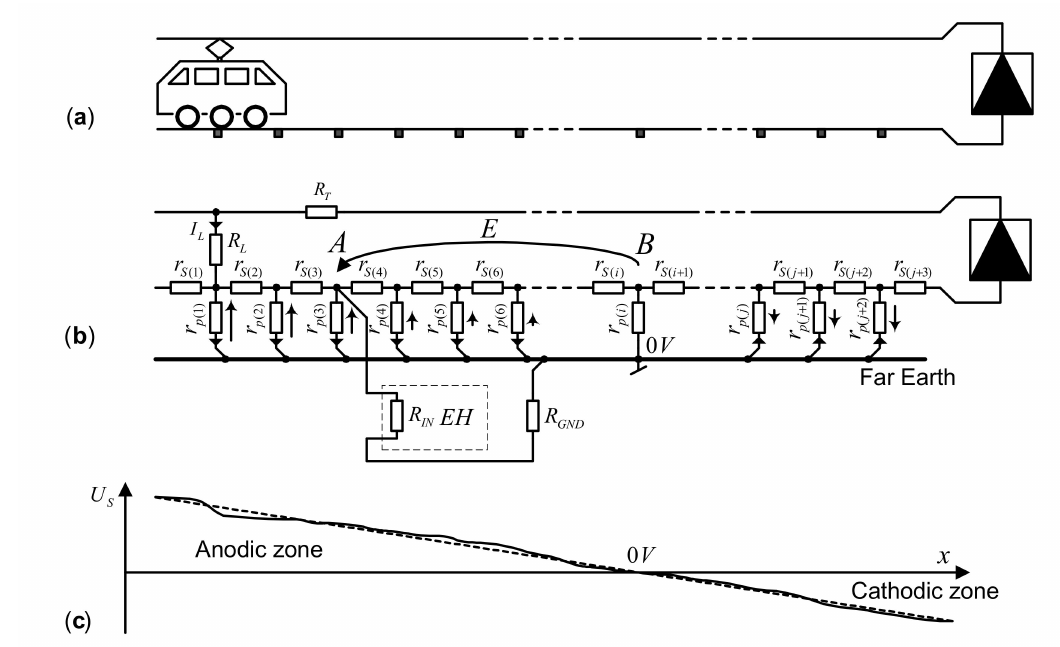
Figure 1. A basic model to analyse the flow of the currents for electrified tracks: ( a ) Railway traction network; ( b ) Model of an overhead contact line with the return line and the location of an energy harvesting (EH) device that uses the phenomenon of stray currents. The arrows beside r p(i) are the voltage drops on r p(i) ; ( c ) Example of dependence of the rail potential to the earth vs distance.